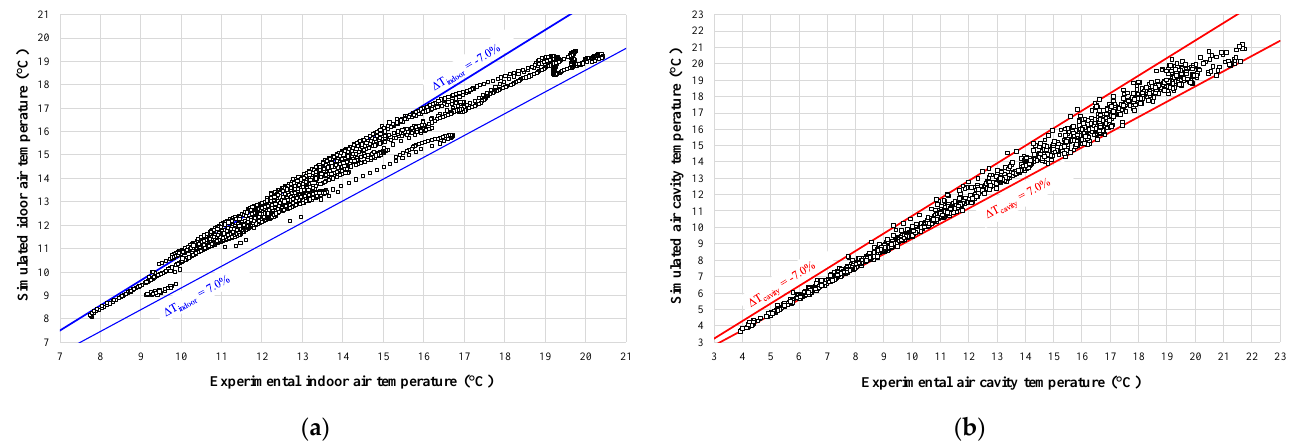
Figure 10. Comparison between the simulated values and the experimental values acquired during the whole test period in terms of ( a ) T indoor and ( b ) T cavity .